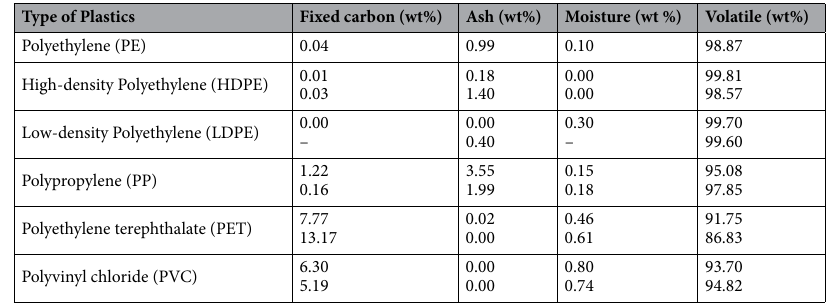
Table 1. Properties of plastic materials 24